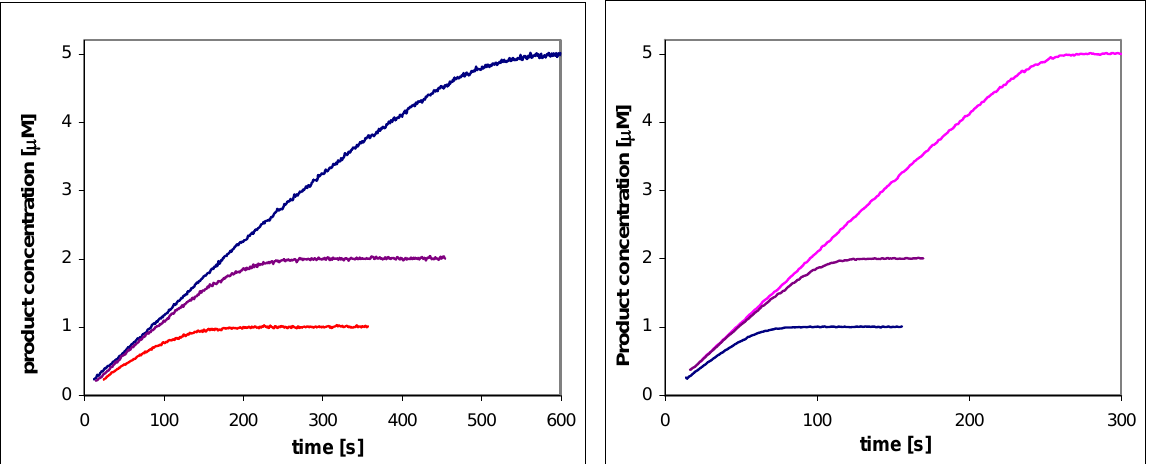
Figure 3. The Lineweaver-Burk plot for the enzymatic oxidation of 2 μ M MONAL catalyzed by the recombinant ALDH3A1. Rates were obtained by numerical differentiation is 0.16 μ M. of the progress curve from Fig. 2. The fitted K m